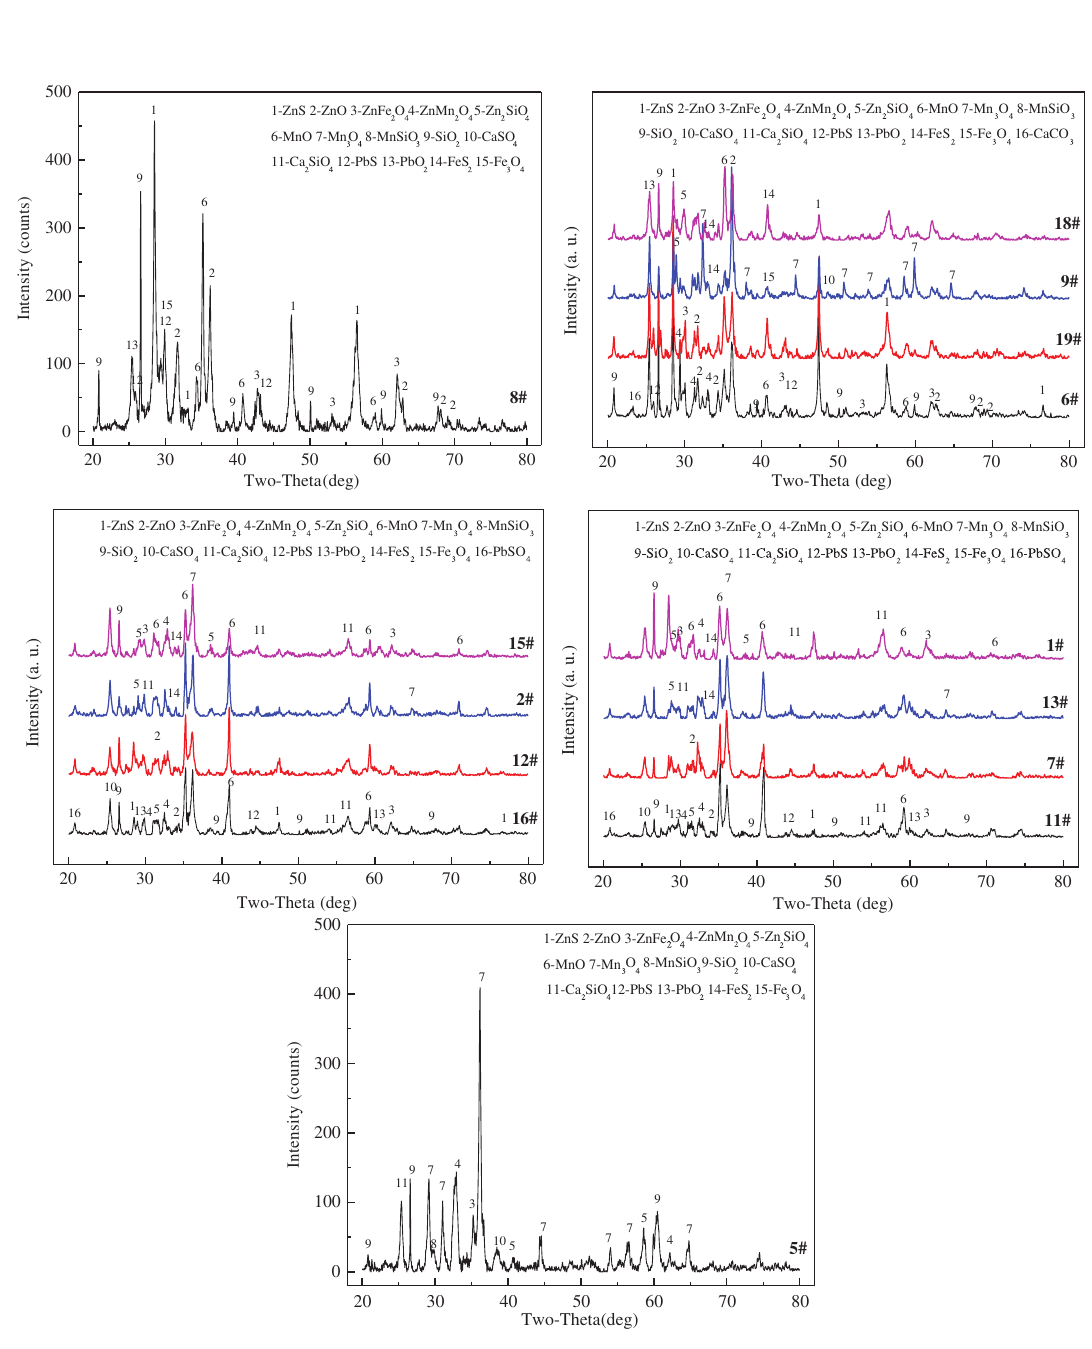
Figure 3: XRD patterns of zinc